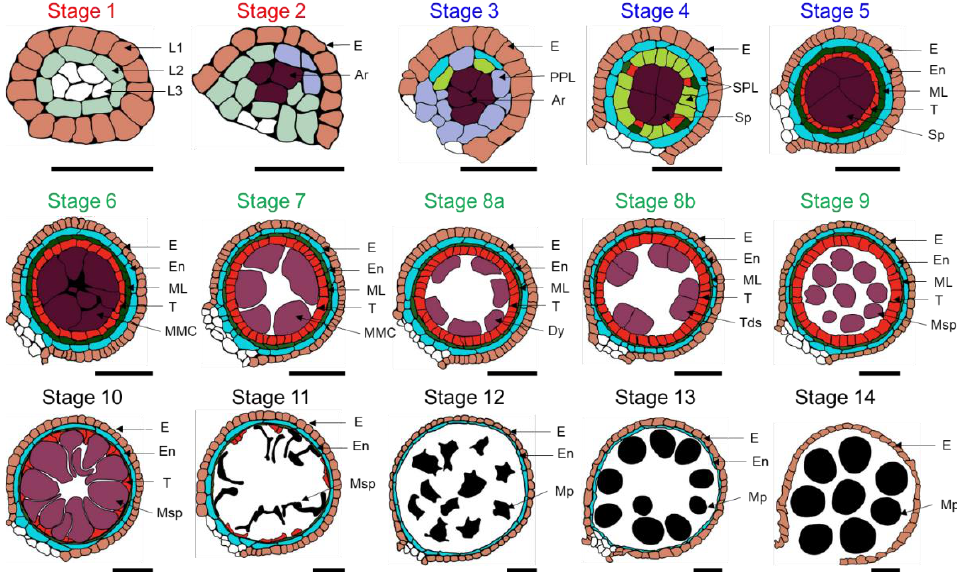
Figure 2. Simulated graphs of maize anther development with 14 stages covering four phases. Developmental stages belonging to phase I, II, III, and IV are labeled in red, blue, green, and black respectively. Ar: archesporial cell; Dy: dyad cell; E: epidermis; En: endothecium; L1, L2, L3: the three cell layers in stamen primordia; ML: middle layer; MMC: microspore mother cell; Mp: mature pollen; Msp: microspore; PPL: primary parietal layer; Sp: sporogenous cell; SPL: secondary parietal cell layer; T: tapetum; Tds: tetrads. Scale bars = 50 μm.